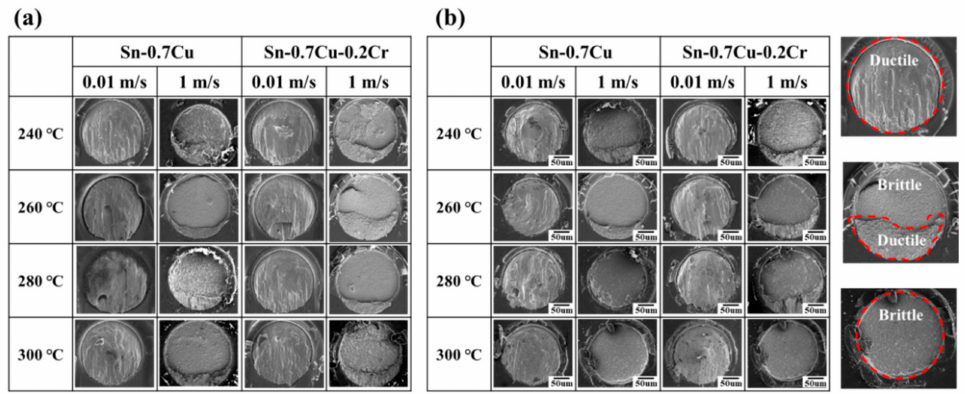
Figure 14. Fracture surfaces of the solder joints at dipping times of ( a ) 1 and ( b ) 3 s for different shear speeds under various reaction